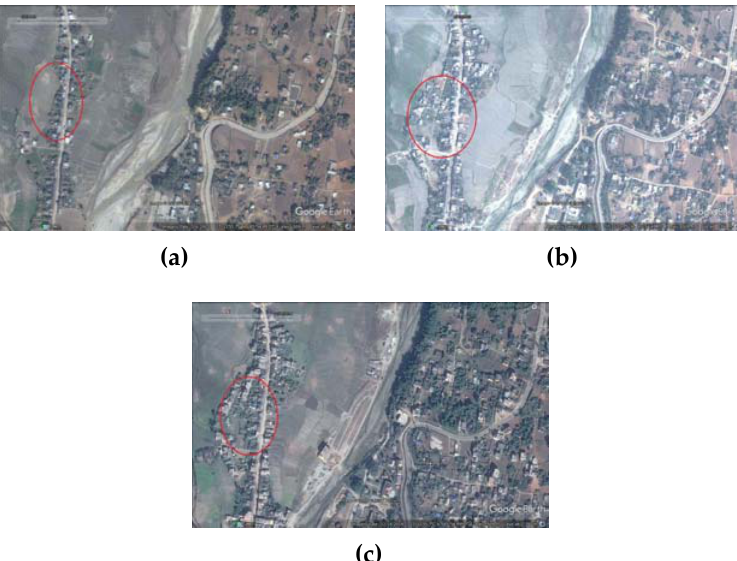
Figure 4. Land use change observed through google earth along Kamalamai municipality in ( a ) 2005, ( b ) 2010 and ( c ) 2014.